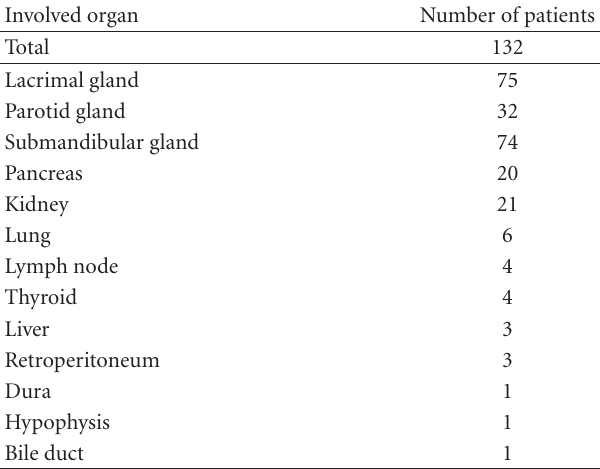
Table 1: Involved organs in 132 patients with IgG4-RD. More than half (64 cases) the patients in our series had so-called Mikulicz’s disease, with symmetrical swelling of at least two sets of lacrimal, parotid, or submandibular